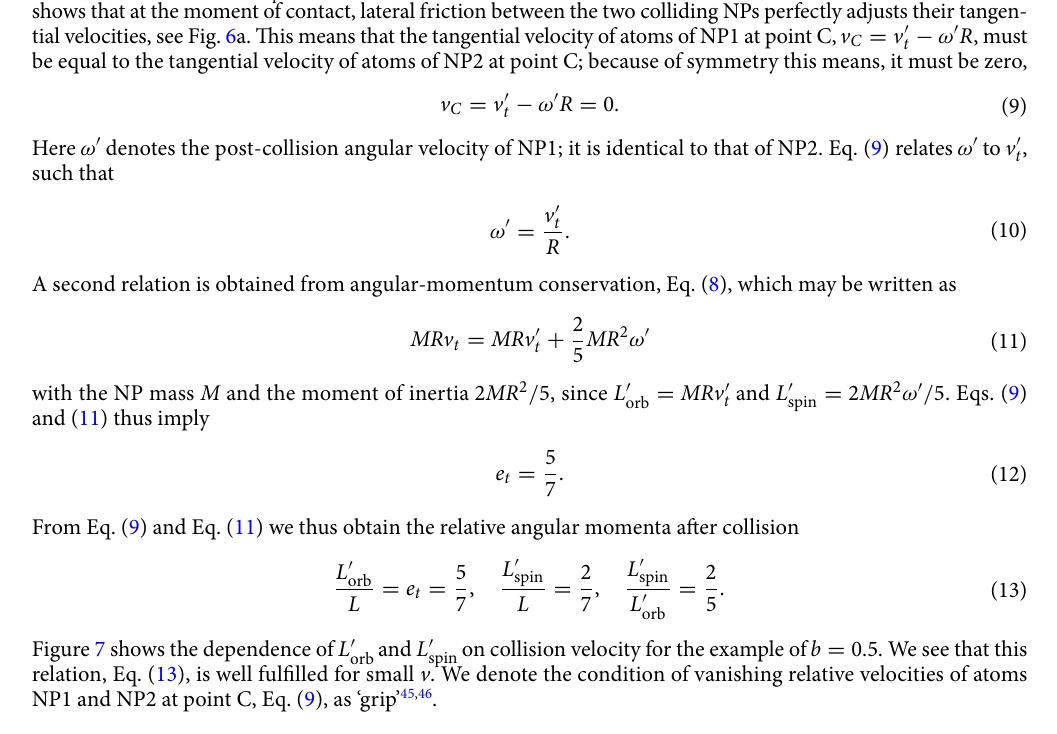
0.05 , ( b ) 0.4, and ( c ) =